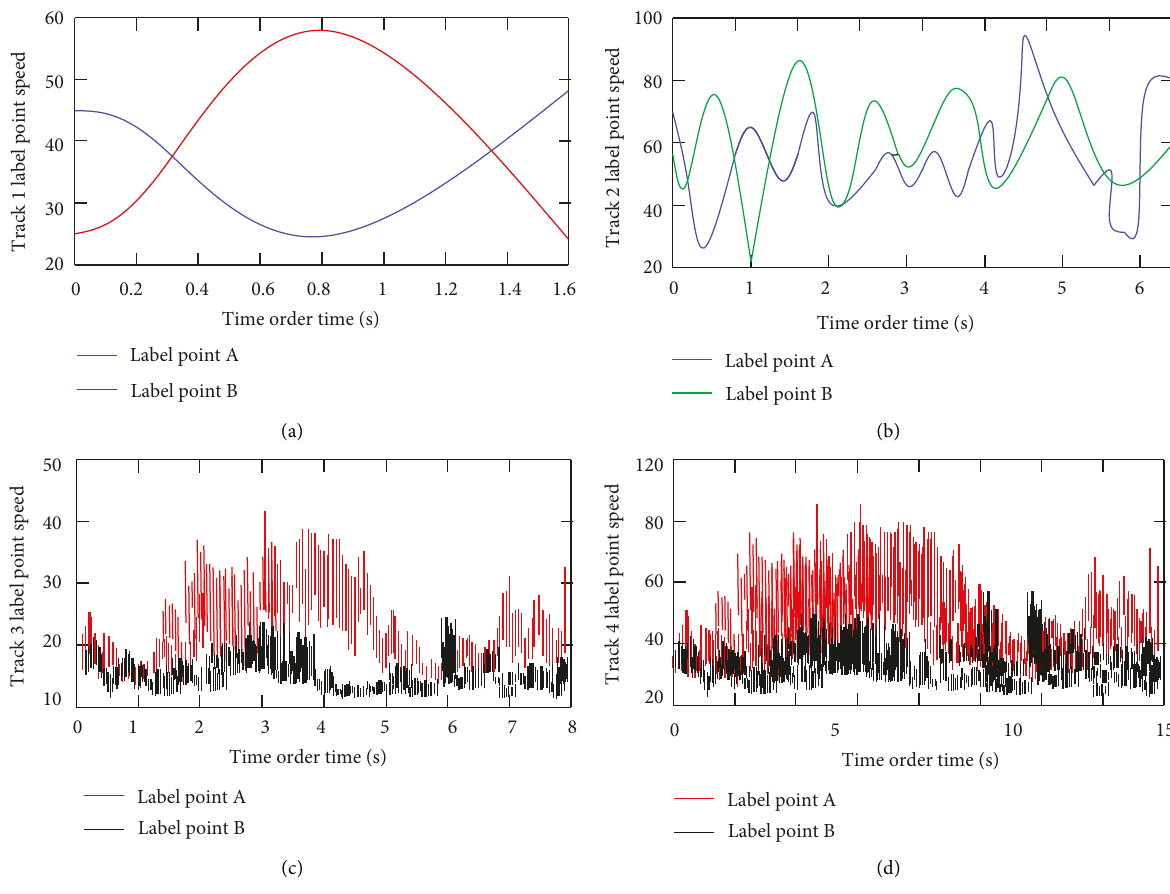
Figure 5: Movement speed of marker trajectories